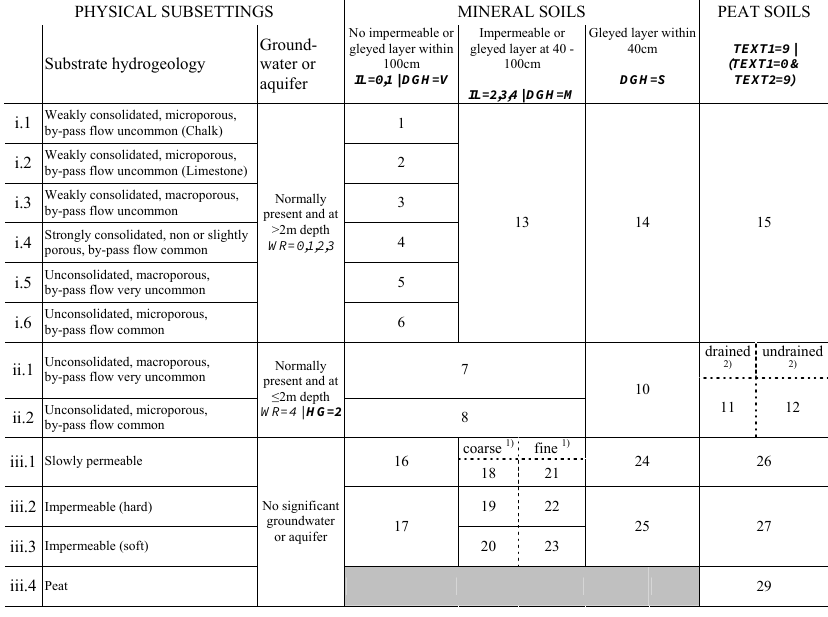
PHYSICAL SUBSETTINGS MINERAL SOILS PEAT SOILS Substrate hydrogeology